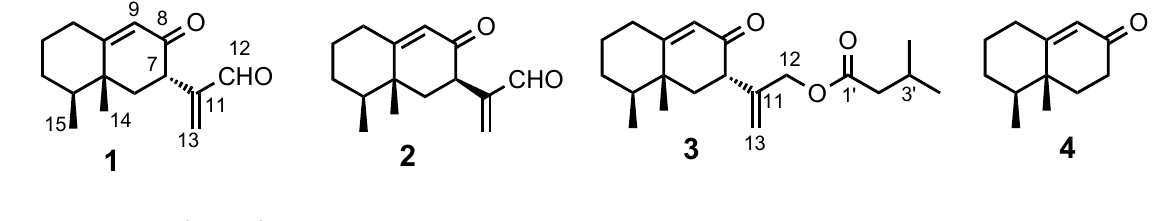
Figure 1. New compounds isolated in this